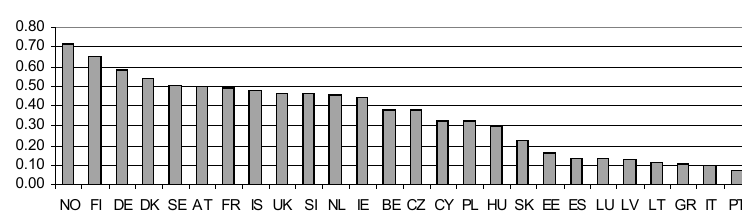
Source: Own analysis of SILC data of 2006. Figure 12 : Effectiveness of transfers: % reduction in lone parent child poverty rates. 0.000.100.200.300.400.500.600.700.80